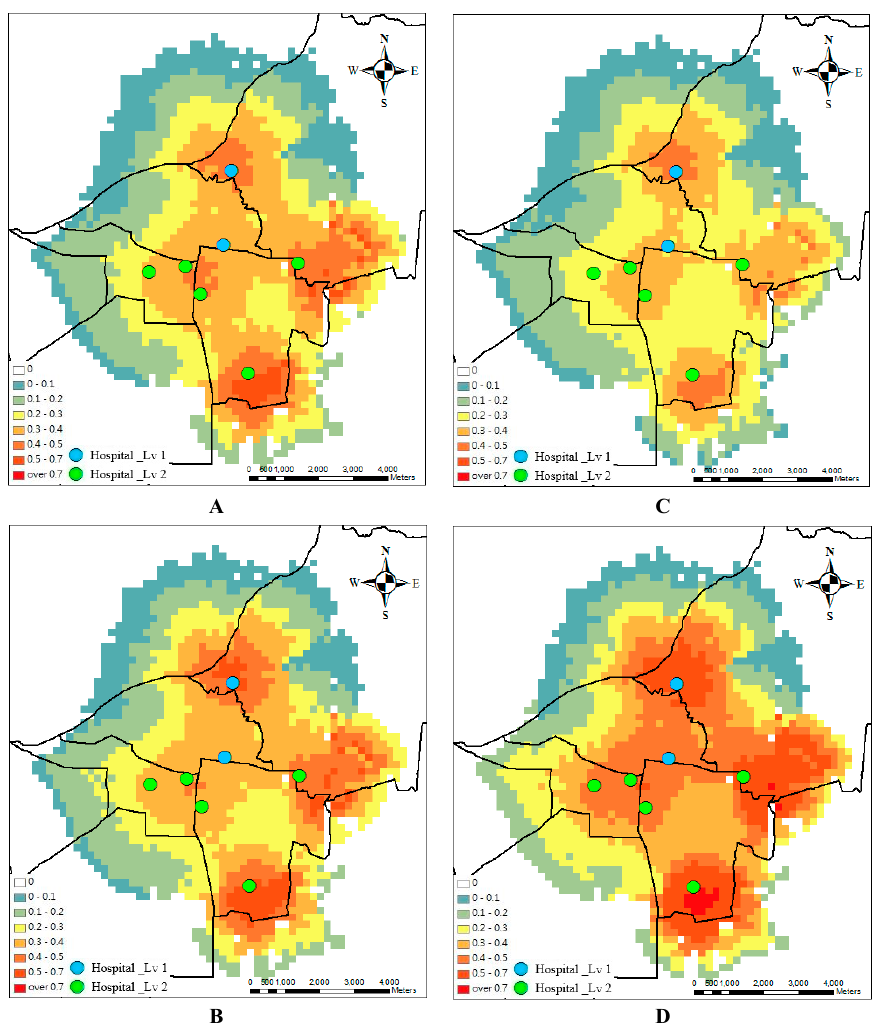
Figure 5. Accessibility after the optimal design at week 1 ( A ); week 2 ( B ); week 3 ( C ) and week 4 ( D ).